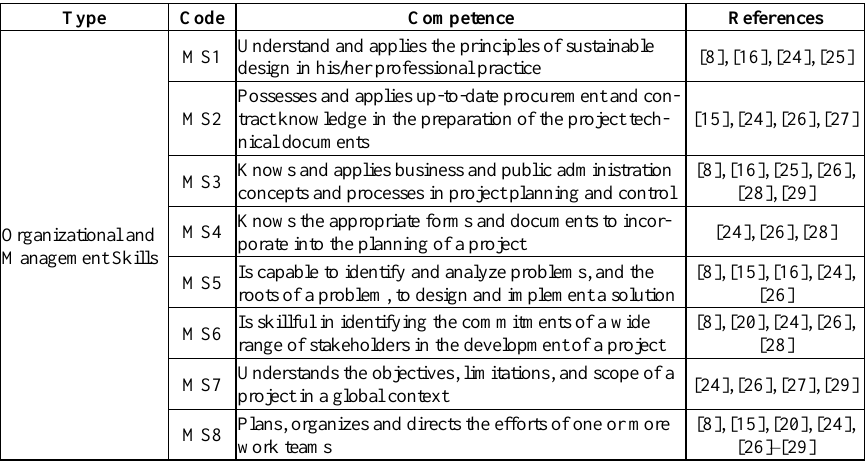
Table 1. Organizational and management skills